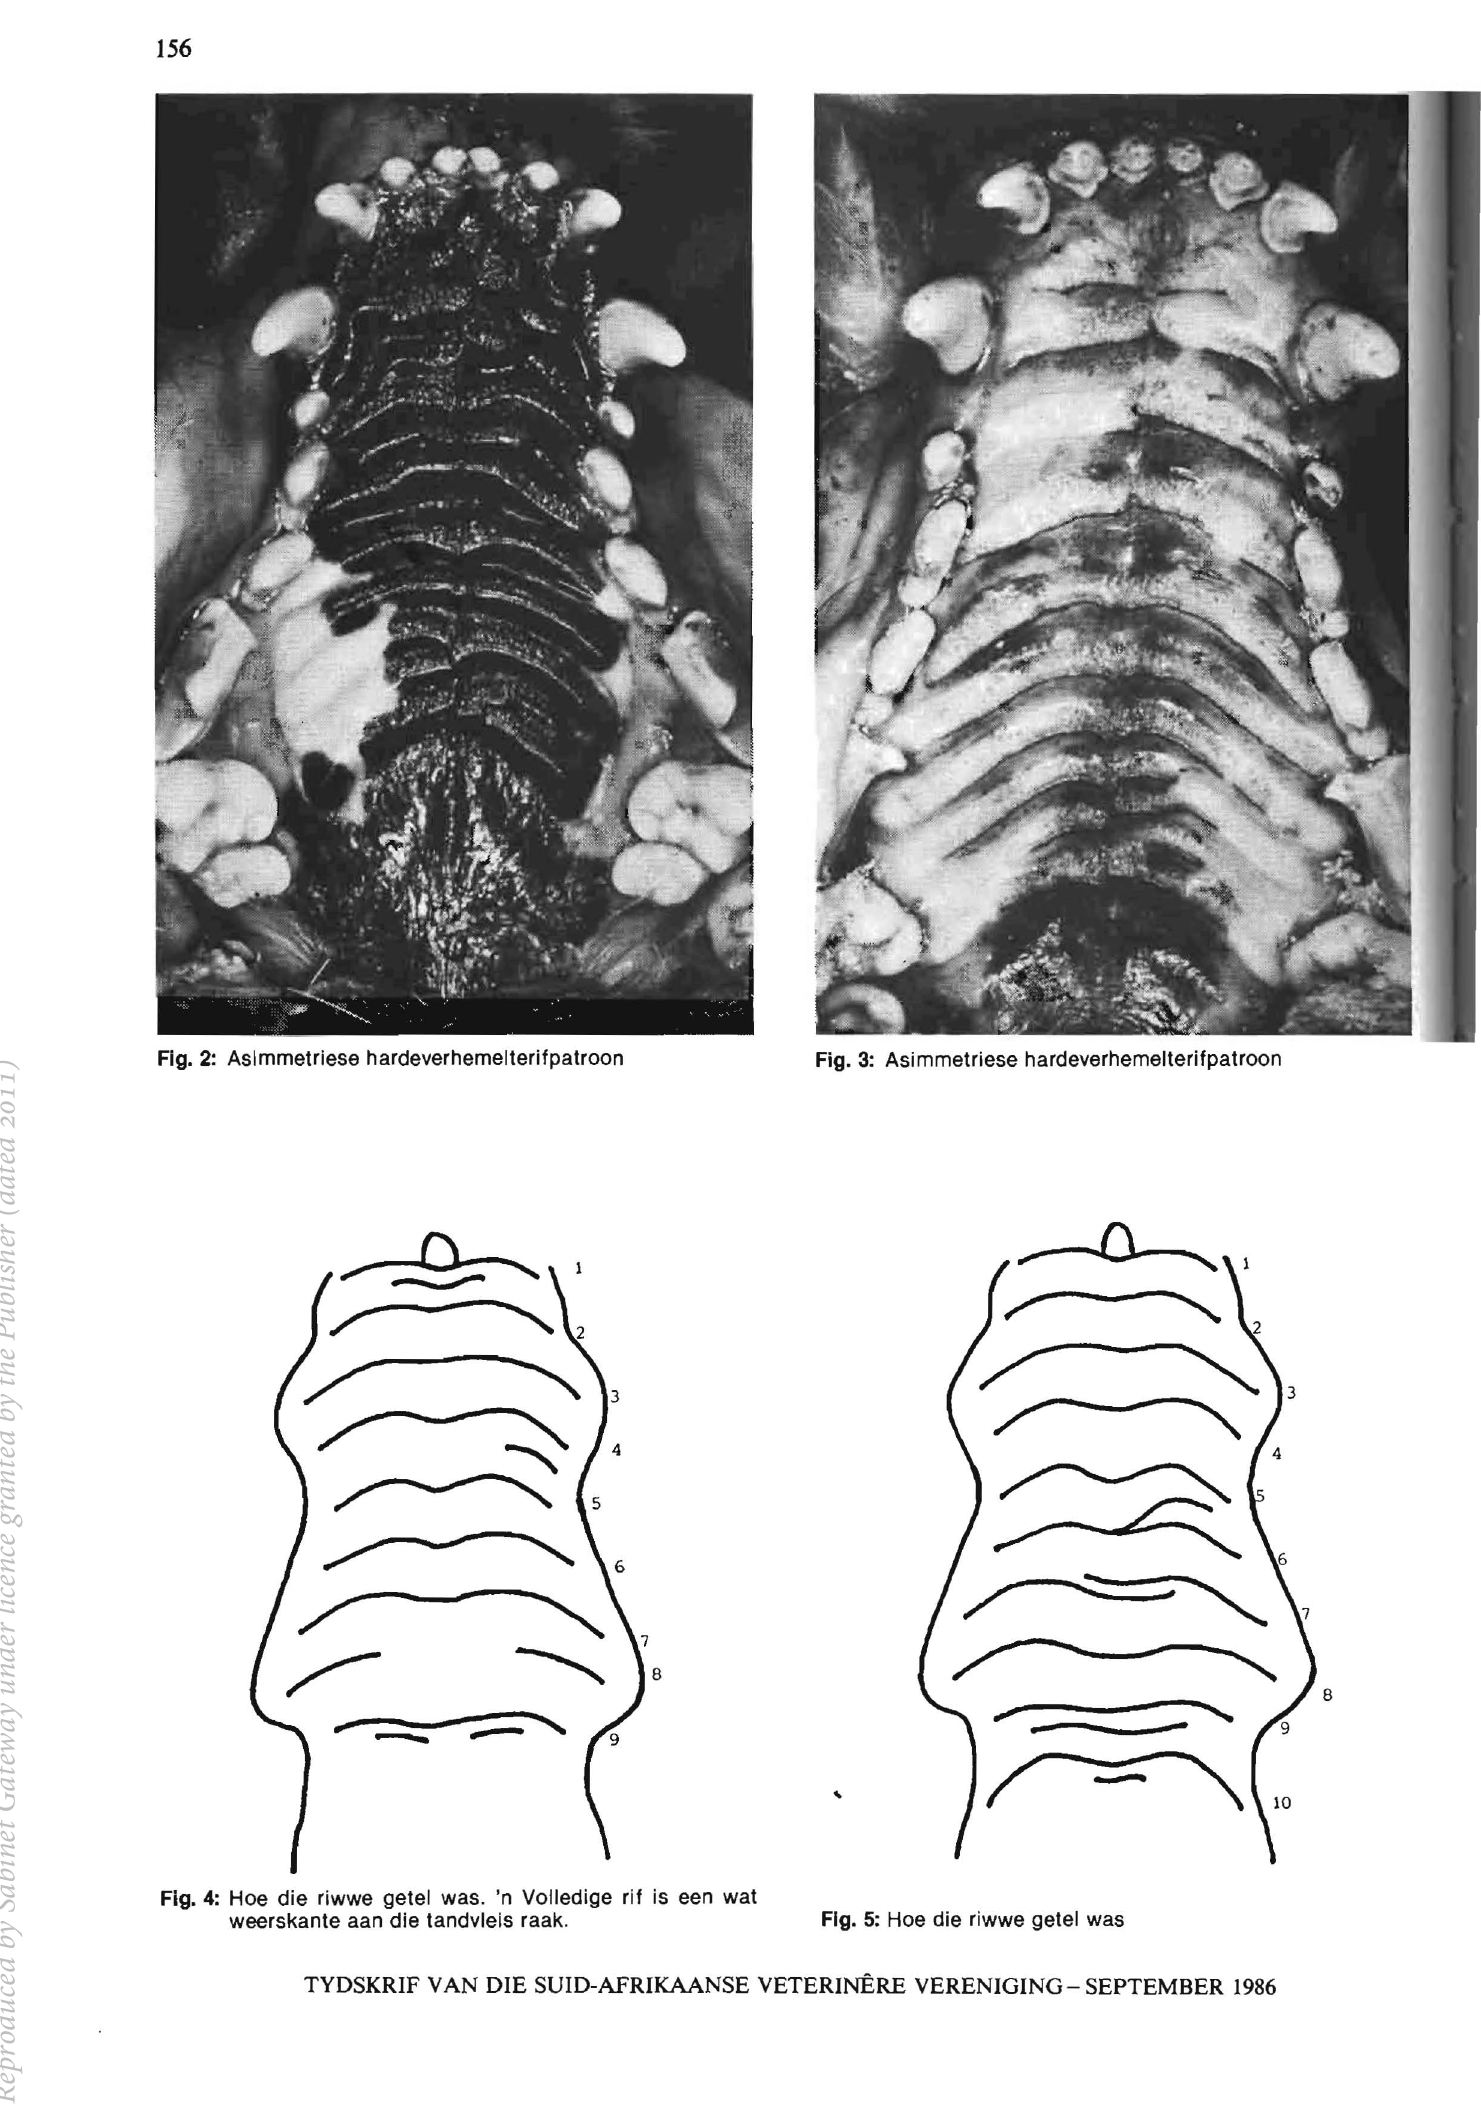
Fig. 4: Hoe die riwwe getel was. 'n Vol'edige rif is een wat Fig. 5: Hoe die riwwe getel was weerskante aan die tandvlels raak. TYDSKRIF VAN DIE SUID-AFRlKAANSE VETERlNERE VERENIGING - SEPTEMBER